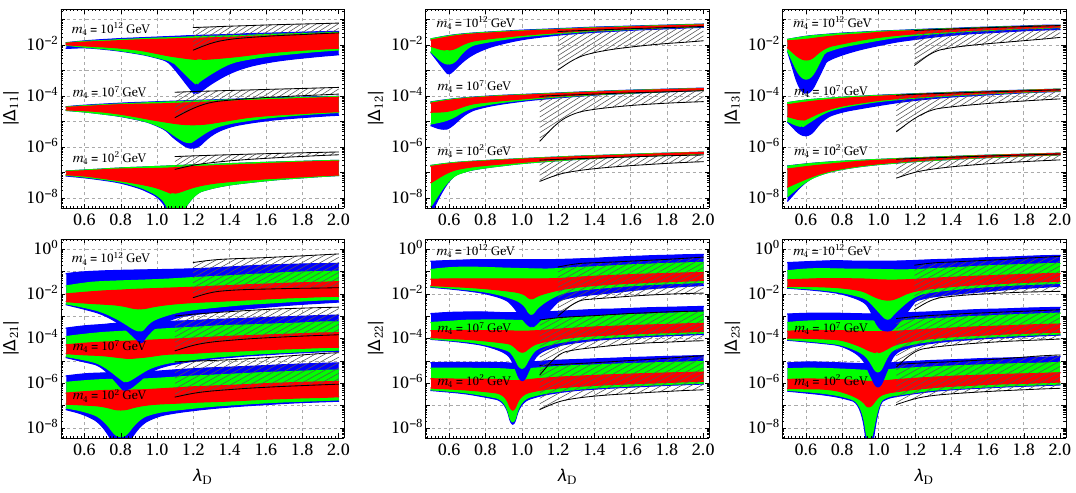
Figure 7 . (Color online) The modulus of the values of the Yukawa couplings (cid:1) 1 and (cid:1) 2 as functions of (cid:21) D for the (cid:12)xed values of m 4 = f 10 2 ; 10 7 ; 10 12 g GeV. The color coding of the ranges is the same as in (cid:12)gure 6, but we do not show the median. Additionally, we show the range of 99% of the values of j (cid:1) jk j for the inverted hierarchy by the striped area. This striped area starts with the values of (cid:21) D = 1 : 1 or (cid:21) D = 1 : 2 because for smaller values of (cid:21) D we do not get enough solutions to derive reliable